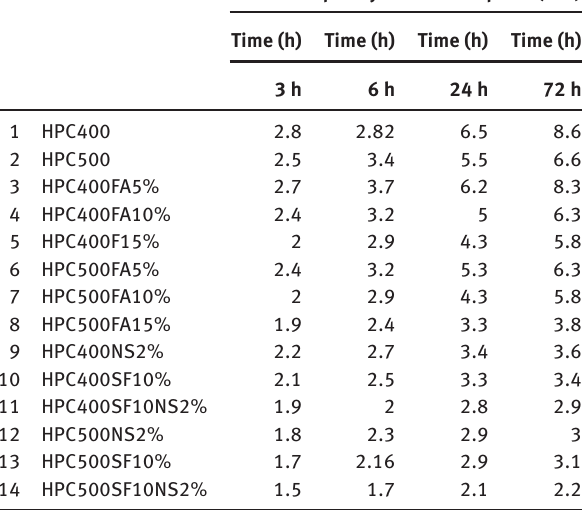
Table 7 Results of capillary absorption by